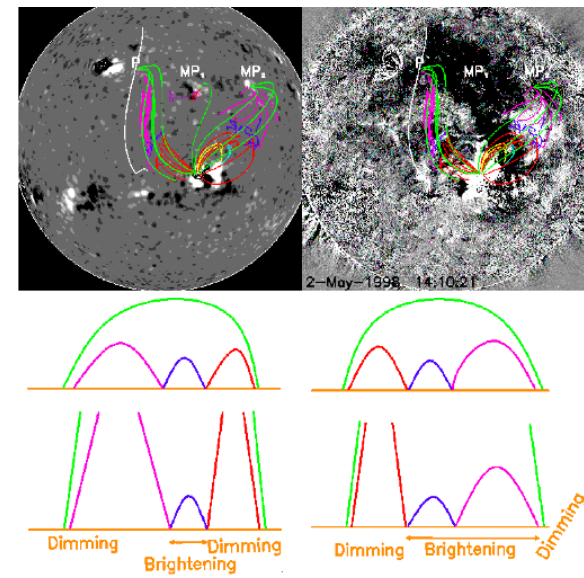
Fig. 8. From Delann´ee et al. (2007) linking dimmings and distant stationary brightenings to location of QSLs in the initial magnetic large-scale topology. The CME is initiated at the southern end of these loops. The cartoons in the lower panel, which have the same colour code as the field lines in the upper panel, illustrate how the stationary brightenings are linked to the expansion of the TEL field lines. The cause of expansion of the TELs, however, remains un-